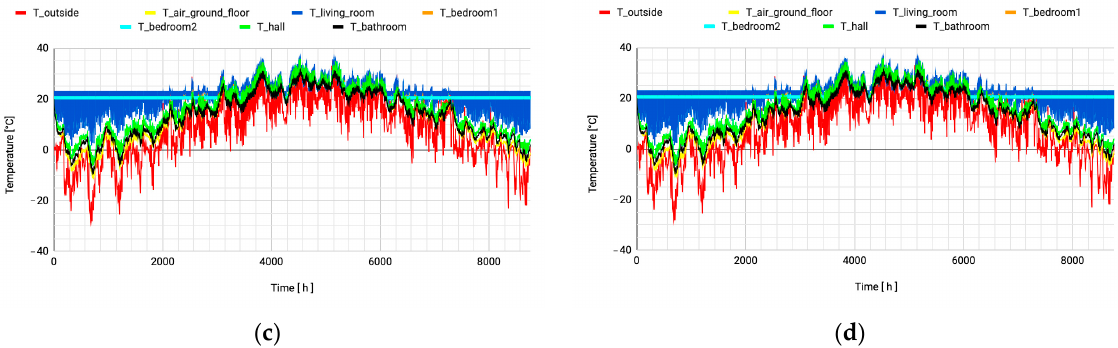
Figure 8. TRNSYS simulation of temperature change: ( a ) current state, ( b ) with sheep’s wool, ( c ) with hemp wool, ( d ) with EPS. The simulation is valid for 8760 h of a typical meteorological year.